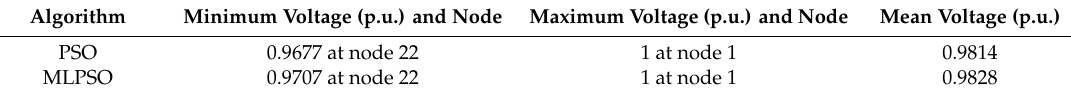
Figure 11. Variation of ( a ) voltage with a single DG, ( b ) convergence characteristics with a single DG, ( c ) voltage with two DGs, ( d ) convergence characteristics with two DGs, ( e ) voltage with three DGs, ( f ) convergence characteristics with three DGs for the Malaysian test system. Table 6. Variation of voltages in PSO, and MLPSO algorithms for three DG scenarios—Malaysian 54 bus system.